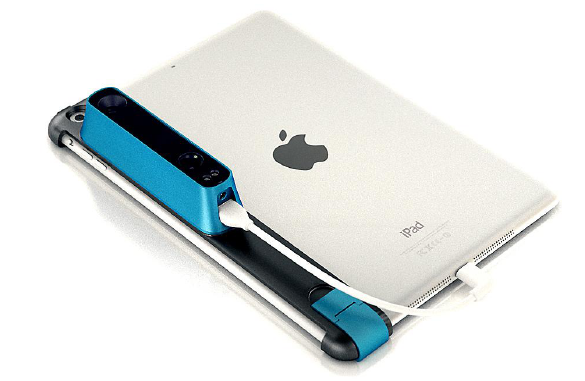
Figure 2: Occipital Structure Sensor attached to an iPad. Image taken from (Hoffman, 2014).